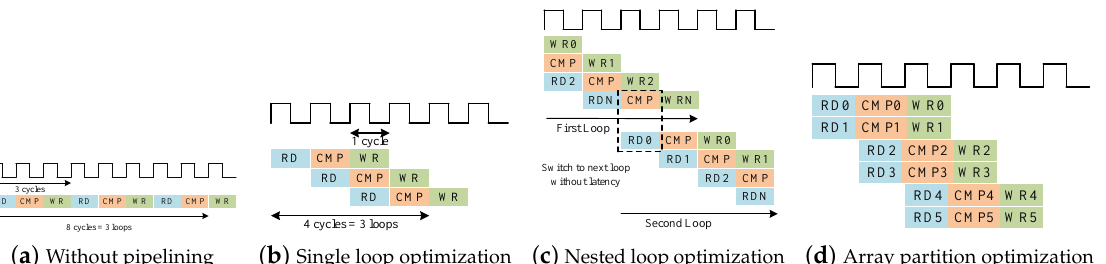
Figure 9. Comparison of processing with and without pipeline [59]. Pipeline can increase the efficiency and speed of the computing process, especially there are sparse hardware resources. According to the application situation, the method can be divided into three categories: single loop optimization, nested loop optimization, and array partition optimization. These techniques can be